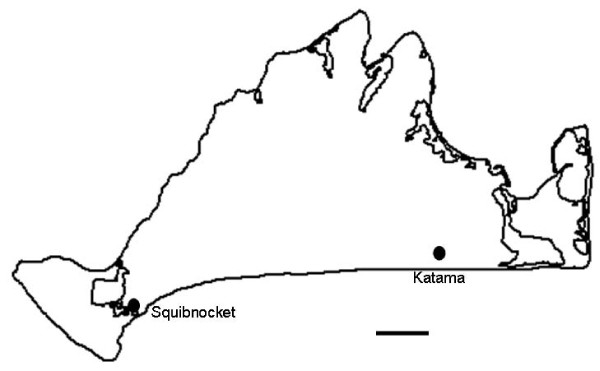
Collection sites on Martha's Vineyard.